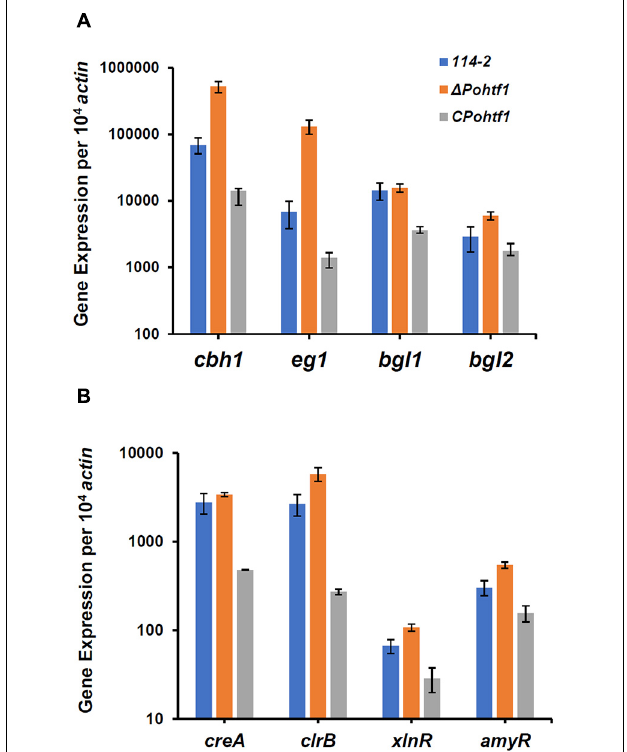
FIGURE 7 | qRT-PCR analysis of the major cellulases and transcriptional regulators in P. oxalicum 114-2, (cid:49) Pohtf1 and C Pohtf1 . (A) Expression levels of the four cellulase genes, cbh1 , eg1 , bgl1 , and bgl2 ; (B) Expression levels of the four transcriptional regulator genes, creA , clrB , xlnR, and amyR . All strains were incubated in the cellulase production medium for 4 h. The gene expression levels were measured by